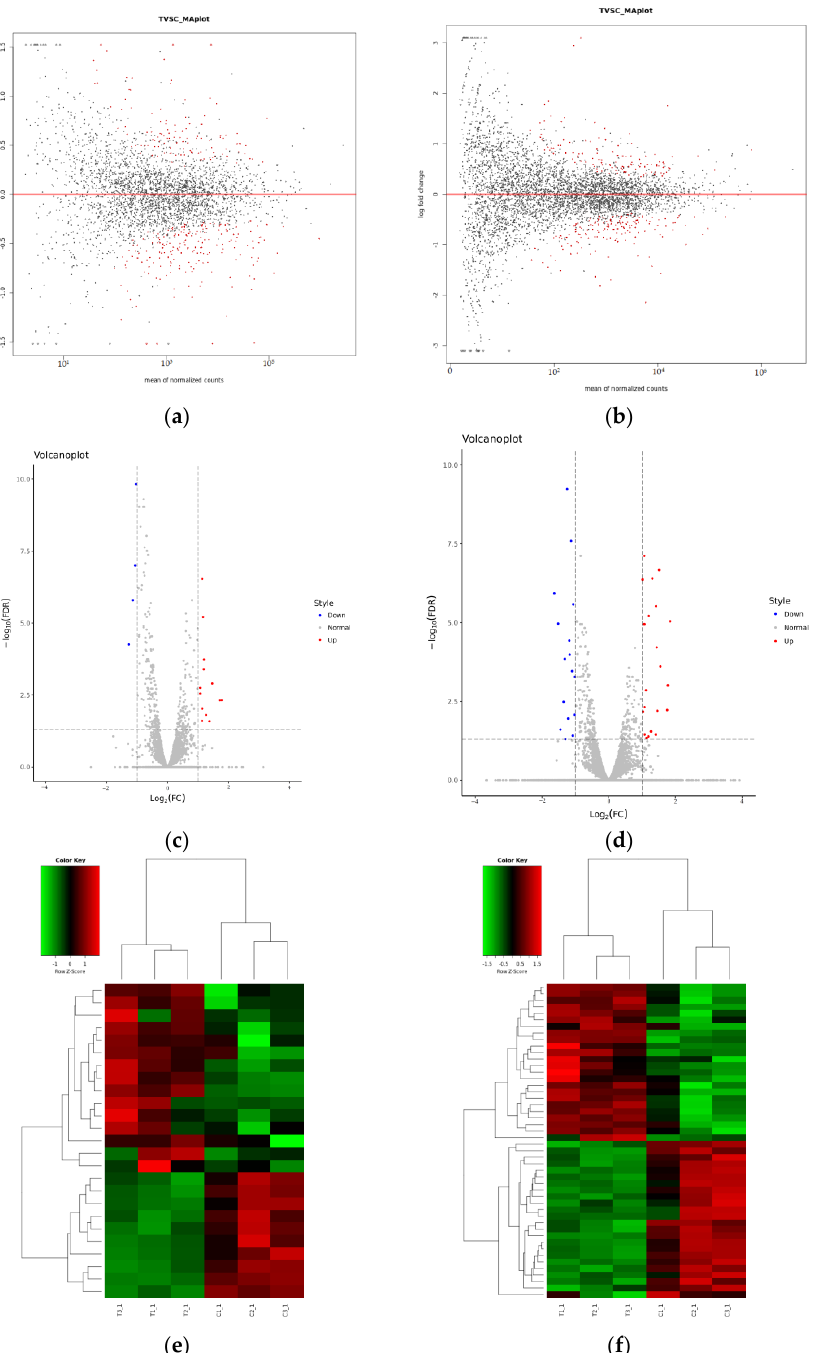
Figure 1. ( a ) MAplot of genes detected in response to minocycline. ( b ) MAplot of detected sRNA. Differentially expressed genes and sRNA are shown in red. ( c ) Volcano plot of differentially expressed genes (DGEs) of A. baumannii in the presence or absence of minocycline. ( d ) Volcano plot of differen- tially expressed sRNA. Upregulated or downregulated genes and sRNA with a log2-fold change ≥ 1 are shown in red and blue. ( e ) Expression heat map of DGEs. ( f ) Expression heat map of differentially expressed